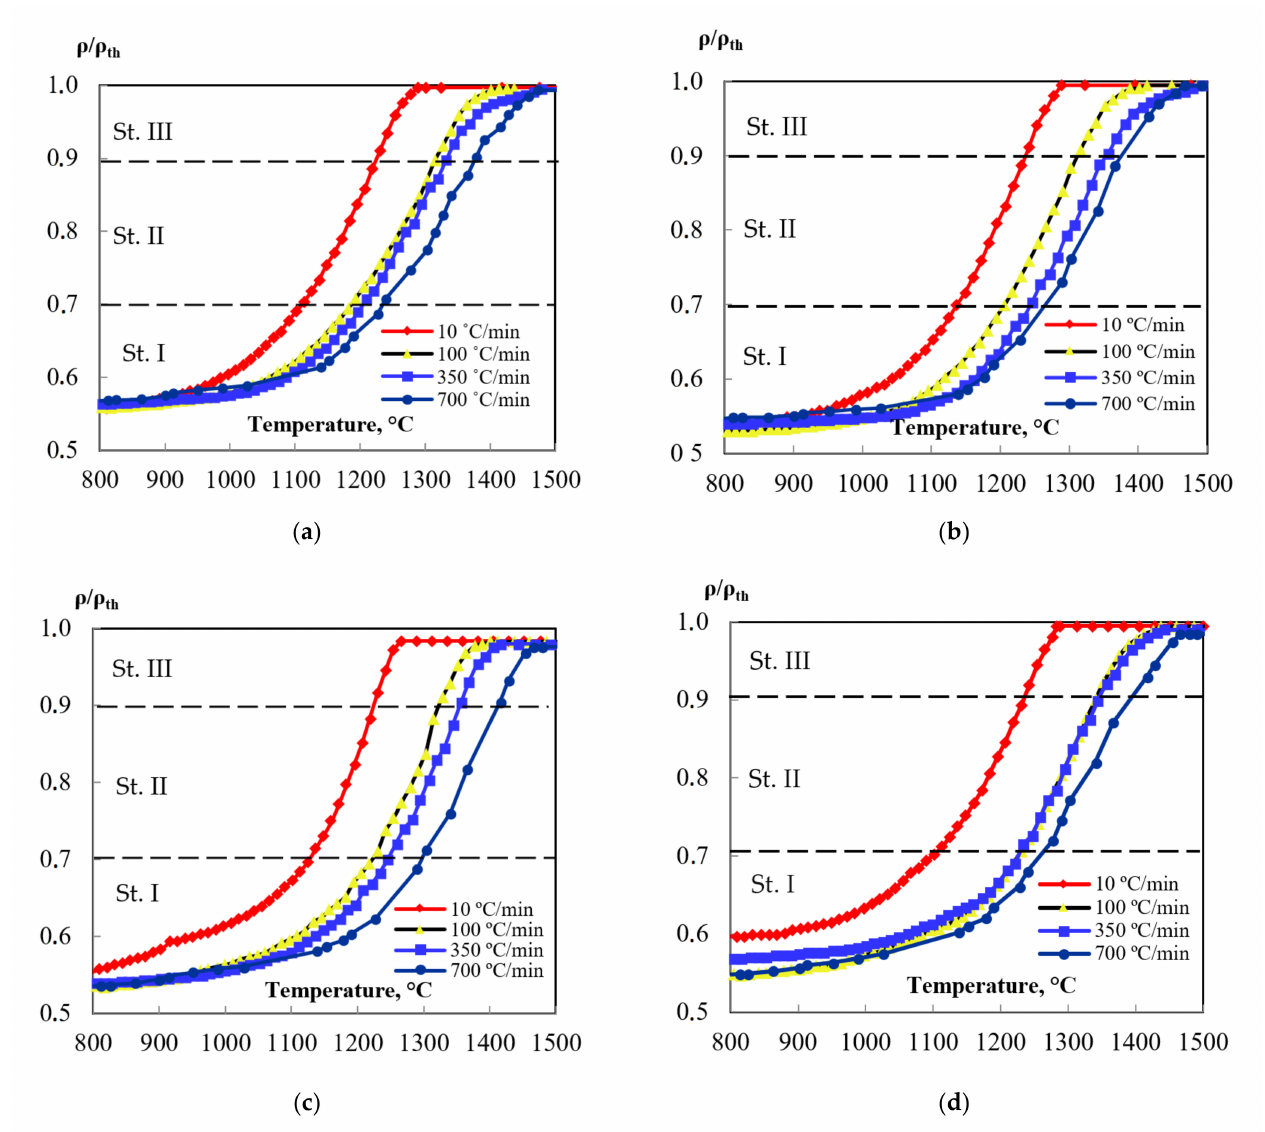
Figure 2. Shrinkage behaviors ρ / ρ th ( T ) for: ( a ) α -Al 2 O 3 , ( b ) Al 2 O 3 + 0.5% vol. MgO, ( c ) Al 2 O 3 + 0.5%vol. TiO 2 , ( d ) Al 2 O 3 + 0.5%vol. ZrO 2 —from the PhD thesis